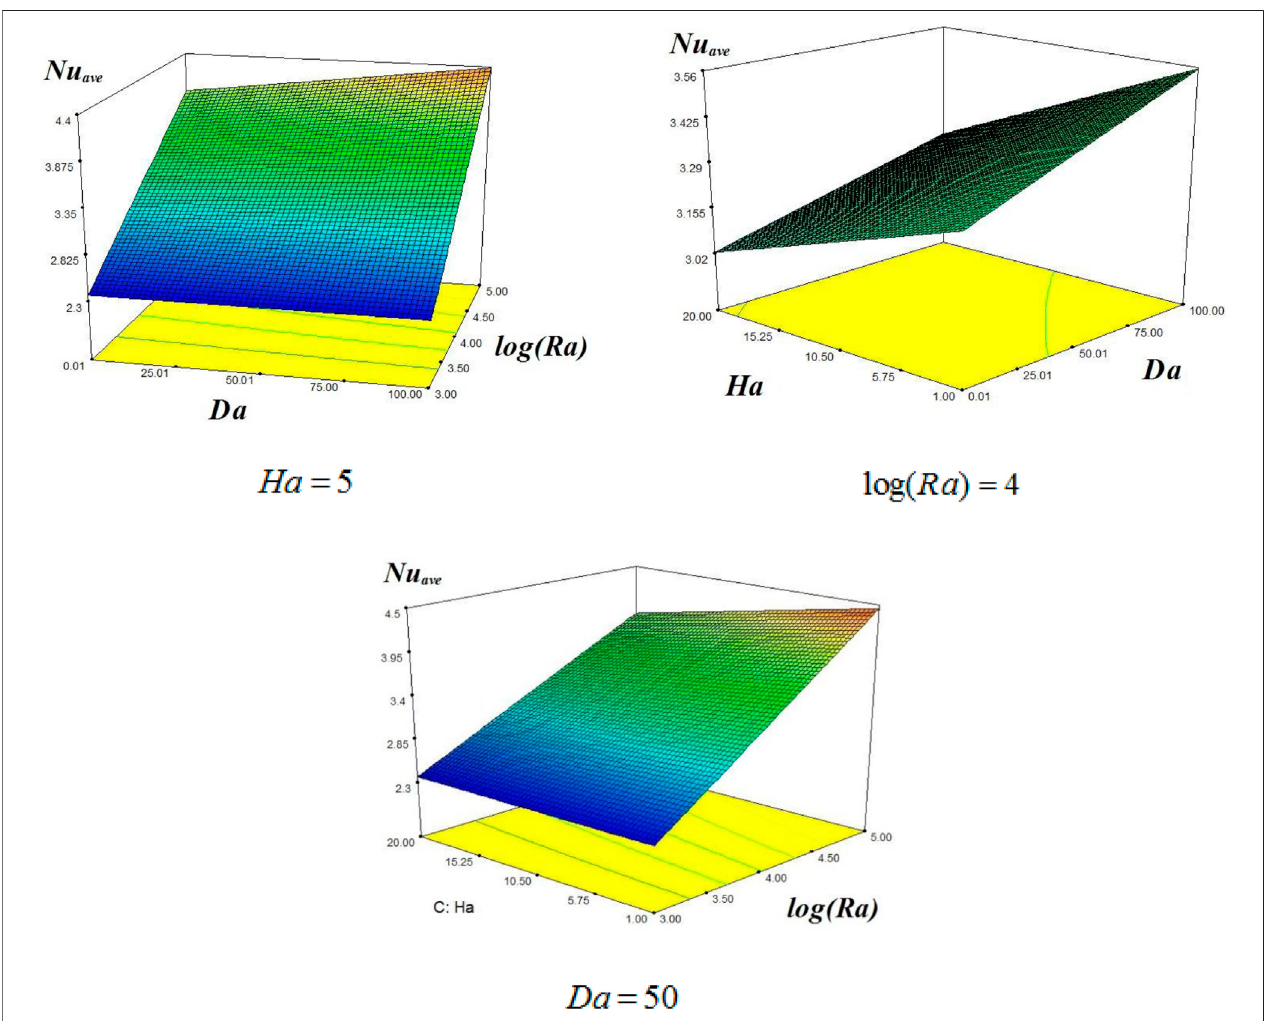
FIGURE 6 | Nu ave values for different